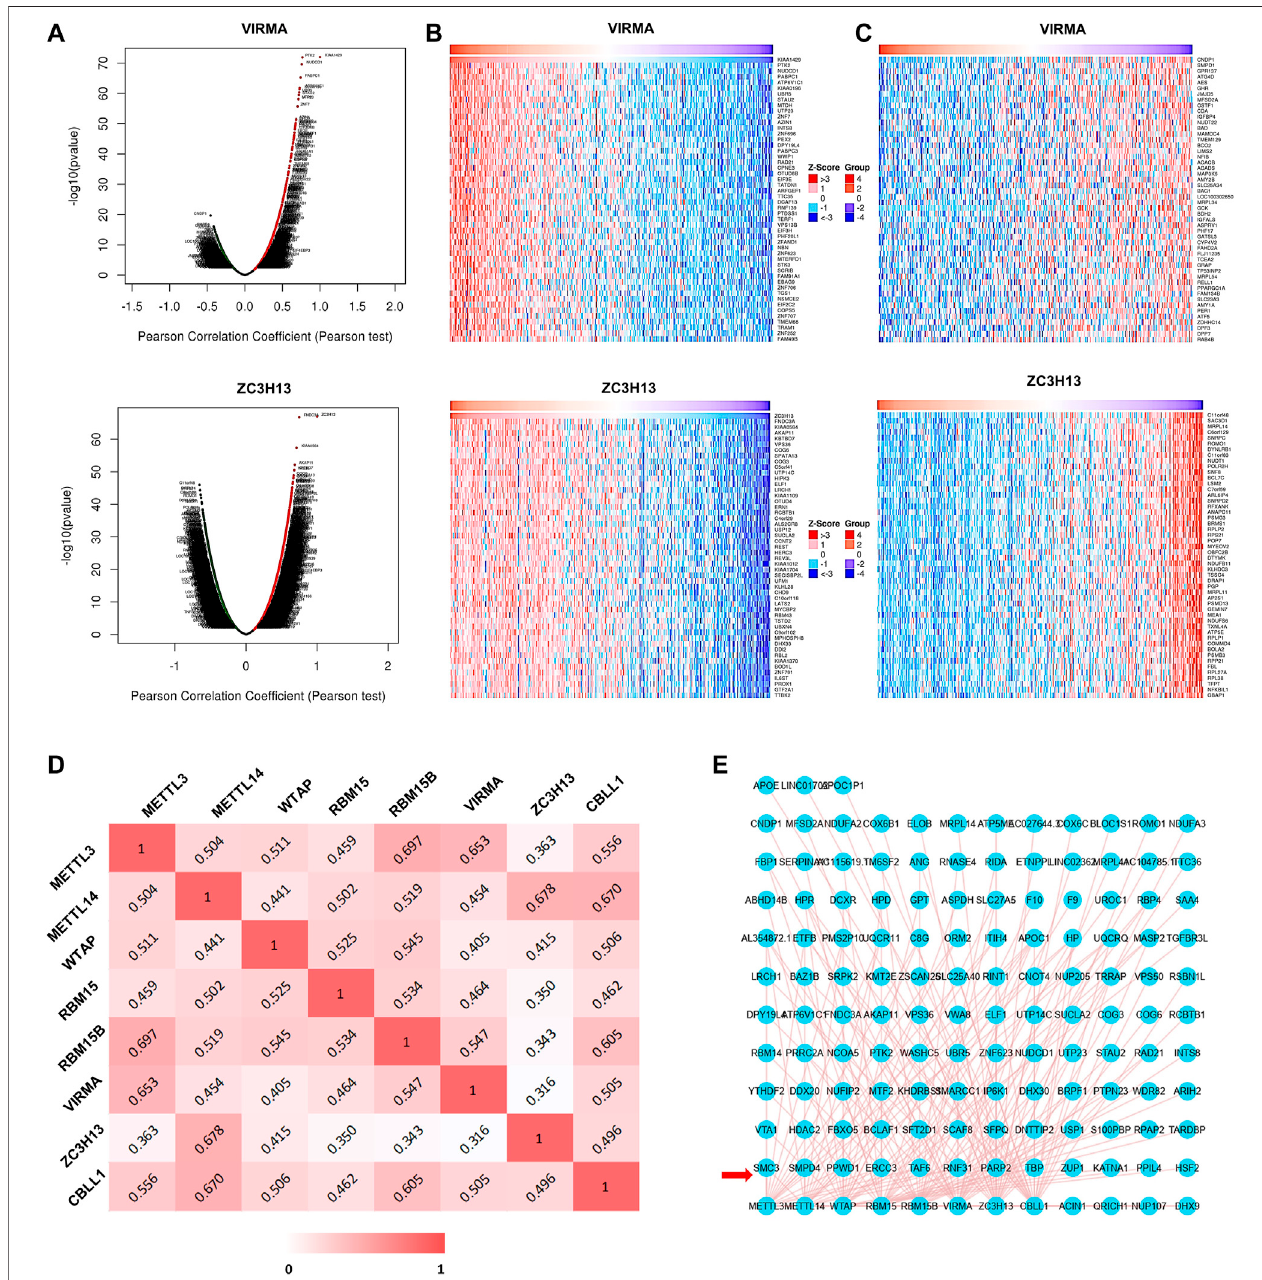
FIGURE7| Coexpressedgenesandinteractionsofthem 6 AwritercomplexinHCC. (A) Volcanoplotsshowdifferentiallyexpressedgenesrelatedtothem 6 Awriter complex in HCC (LinkedOmics). Heatmaps show the top 50 genes positively (B) and negatively (C) correlated with the m 6 A writer complex in HCC (LinkedOmics).Redindicatespositivelycorrelatedgenes,andblue/greenindicatesnegativelycorrelatedgenes. (D)